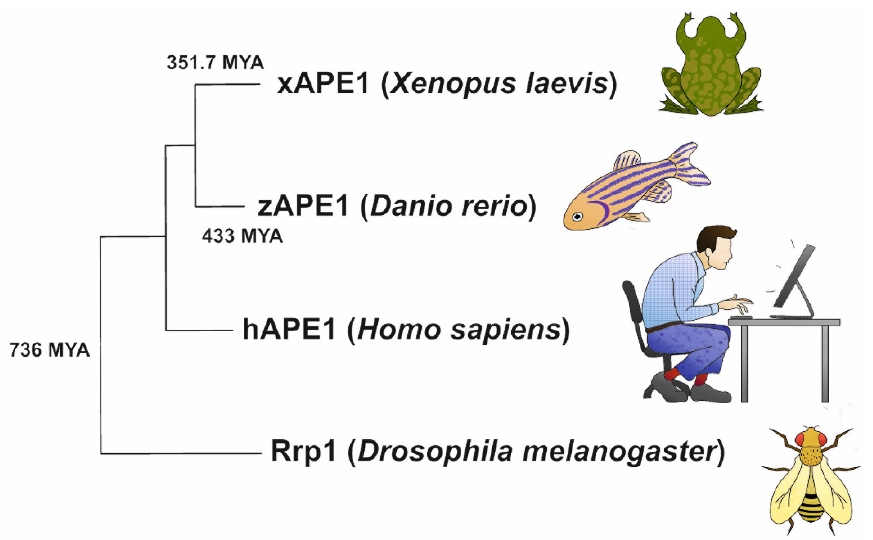
Figure 1. Phylogenetic analysis of the C-catalytic domains of the APE1-like enzymes. Phylogenetic tree was created using the maximum likelihood method (500 replicates) and Jones–Taylor–Thornton (JTT) model by Mega 11 software [44]. Mean divergence times for the species were taken from the TimeTree database and are represented in million years ago (MYA).